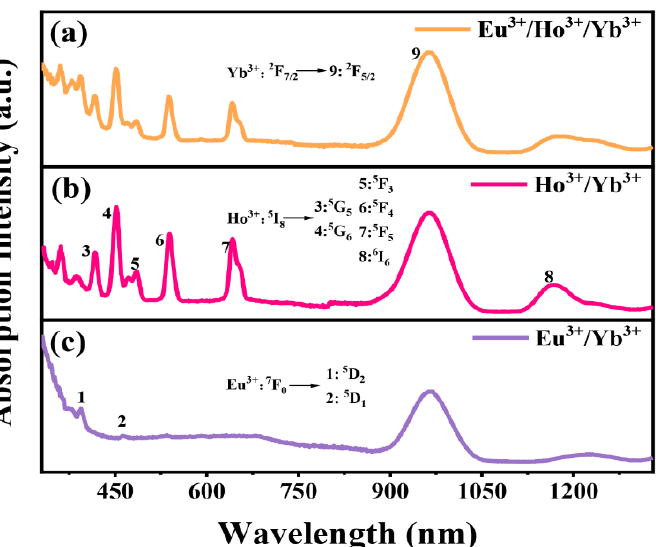
Figure 3. UV-vis absorption spectra of Cs 2 Ag 0.3 Na 0.7 InCl 6 : Yb 3+ /Eu 3+ /Ho 3+ (a), Cs 2 Ag 0.3 Na 0.7 InCl 6 : Ho 3+ /Yb 3+ (b) and Cs 2 Ag 0.3 Na 0.7 InCl 6 : Eu 3+ /Yb 3+ (c) powder. The molar ratios of Yb:In, Eu:In, and Ho 3+ /Yb 3+ ( b ) and Cs 2 Ag 0.3 Na 0.7 InCl 6 : Eu 3+ /Yb 3+ ( c ) powder. The molar ratios of Yb:In, Eu:In,